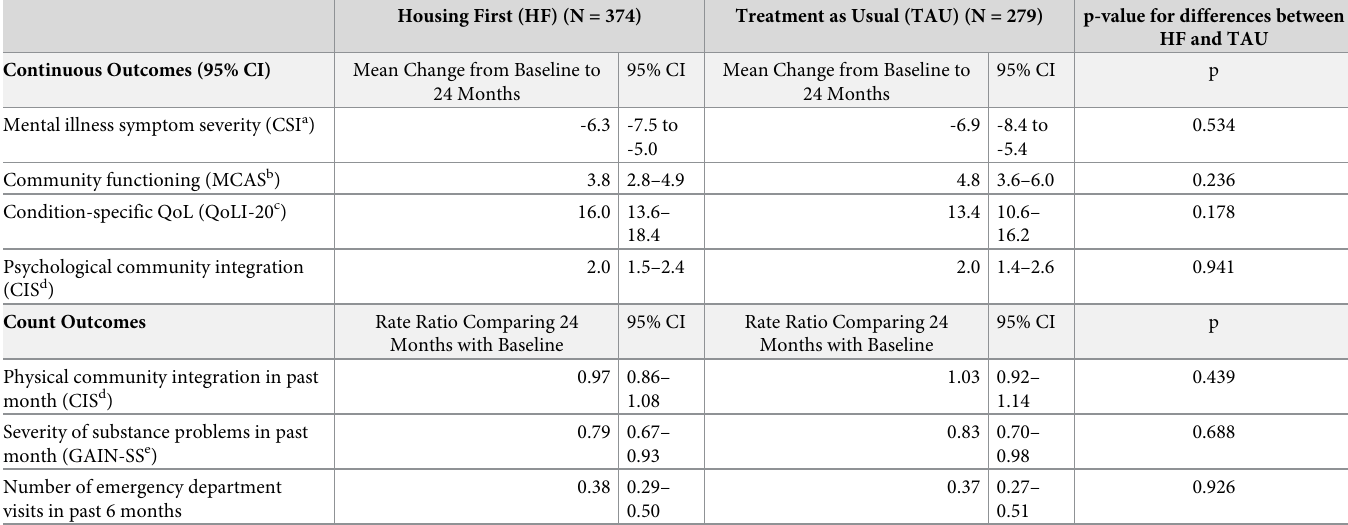
Table 2. Post-imputation pooled change in health and social measures from baseline to 24 months among women living with mental illness and homelessness, adjusted for study city, and need level (ACT or